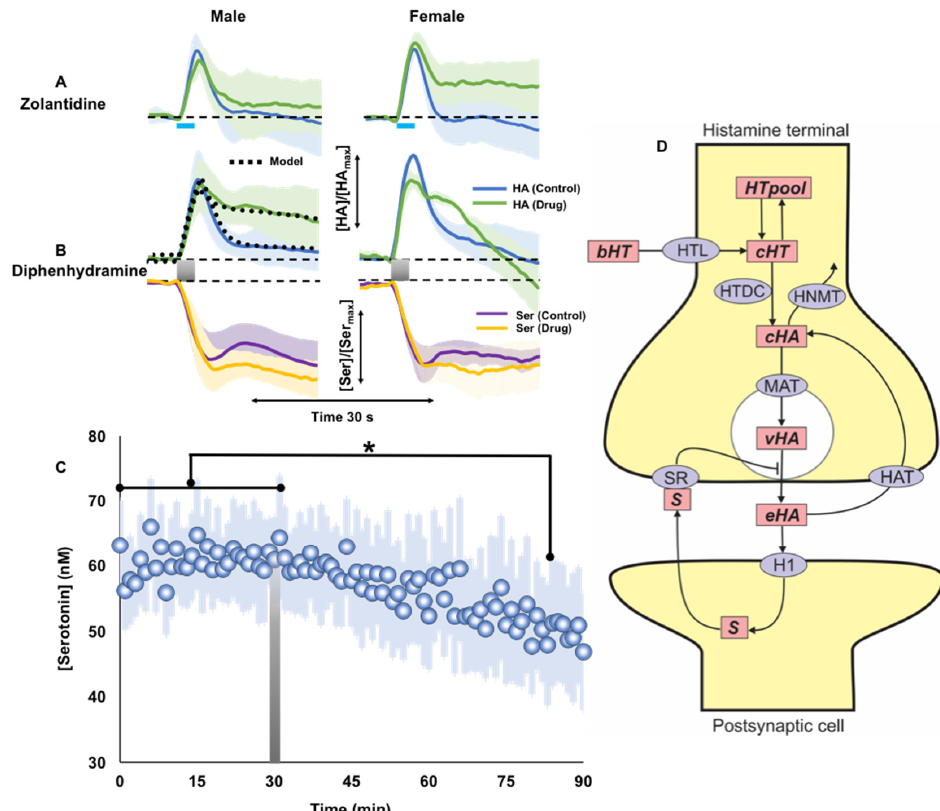
Figure 4. ( A , B ) The drug and mouse’s sex are listed. Concentration vs. time traces for control (blue) and post-drug (green) evoked histamine, and control (purple) and post-drug (orange) inhibited serotonin. The light blue bar and the shaded grey bar represent the 2 s electrical stimulation. The mathematical model’s simulations are in black dotted lines. ( C ) Extracellular ambient serotonin levels in the CA2 region of the hippocampus measured once a minute after a large DPH dose (gray bar) ( n = 5) * is the first data point where the signal is significantly different from control. ( D ) Schematic diagram of histamine transmission via the H1R. Abbreviations: bHT, blood histidine; cHT, cytosolic histidine; HTpool, the histidine pool; cHA, cytosolic histamine; vHA, vesicular histamine; eHA, extracellular histamine; HTL; HTDC, histidine decarboxylase; HNMT, histamine methyltransferase; HAT, the HA transporter; HTL, the histidine transporter, H1, H1R; S, inhibitory retrograde messenger. * = p < 0.05.